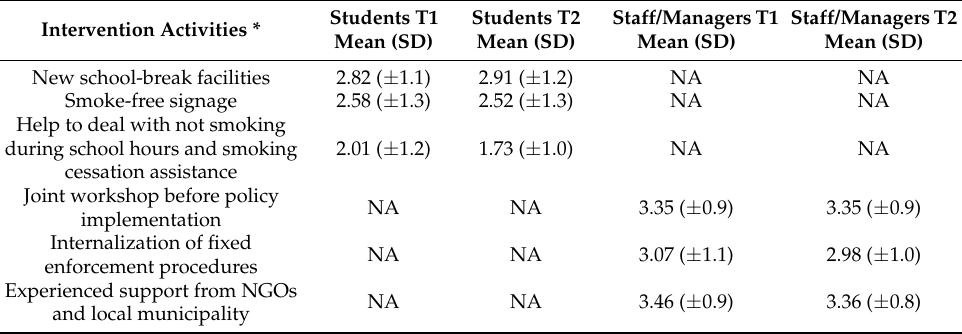
Table 5. Descriptive results regarding intervention activities at T1 and T2—mean values.